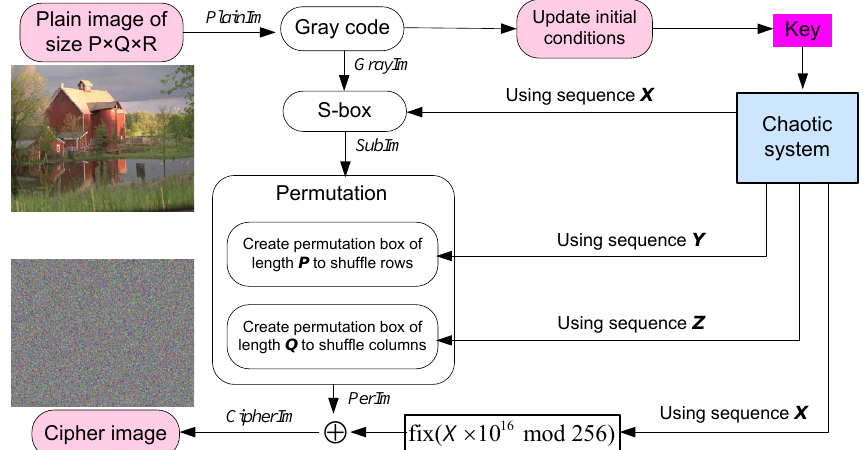
Figure 1. Block diagram of the proposed encryption